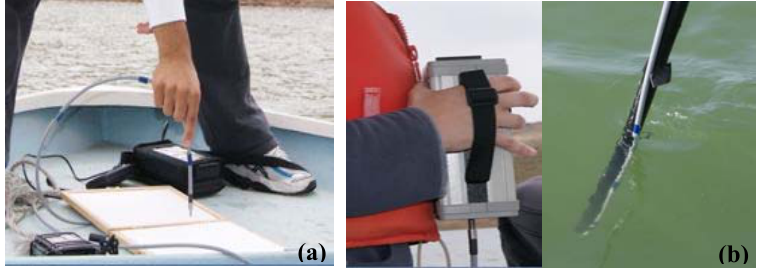
Figure 2. GER1500 field spectroradiometer (a) Reference spectroradiometric measurements on the white spectralon panel (b) Target spectroradiometric measurements using a fiber optic probe.